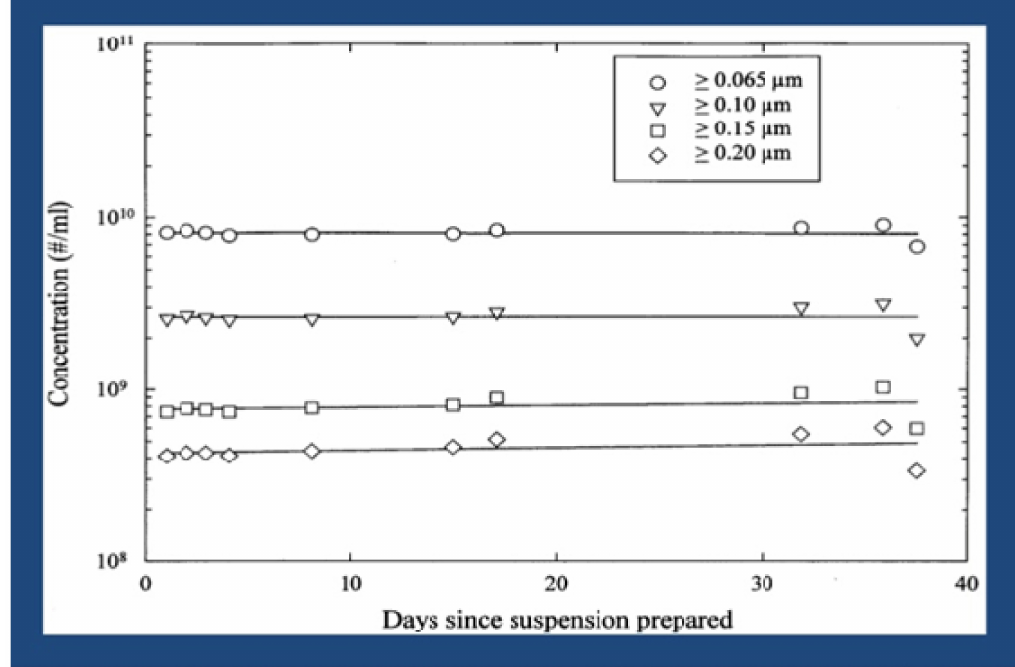
Figure 1. Lipid-coated microbubble / nanoparticle-derived (LCM / ND) nanoemulsion stability over time